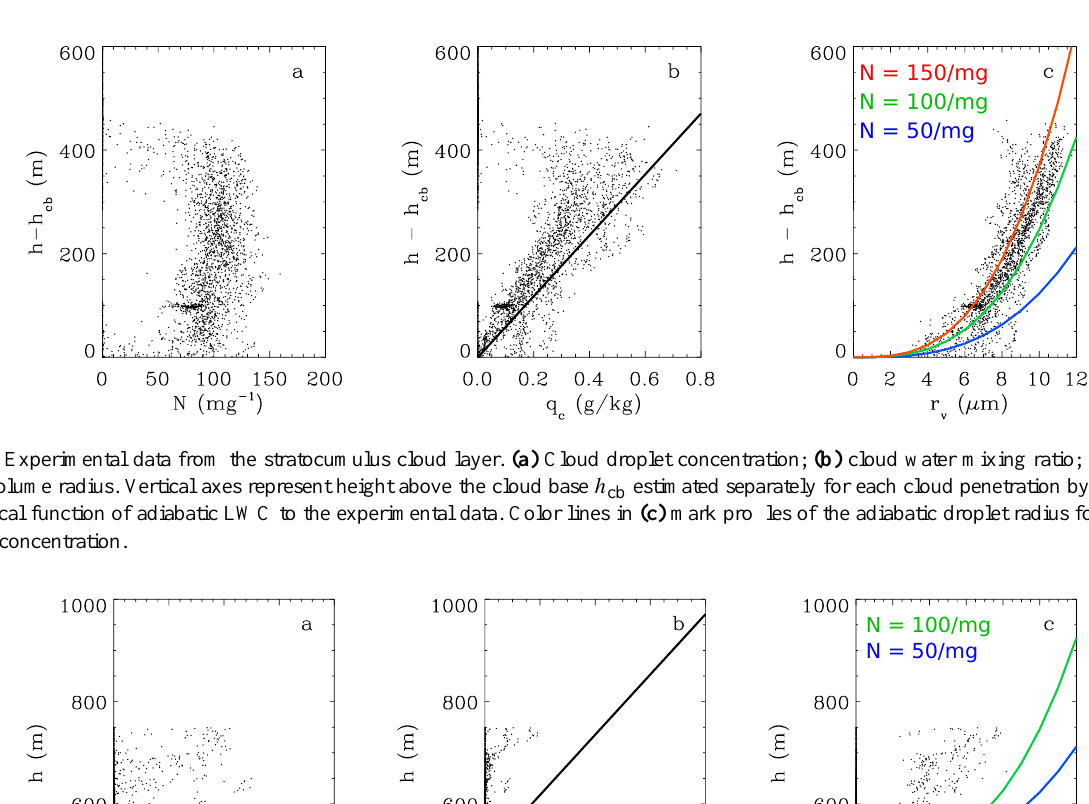
λ 0 (i.e., of the order of the Kolmogorov microscale; ∼ 1